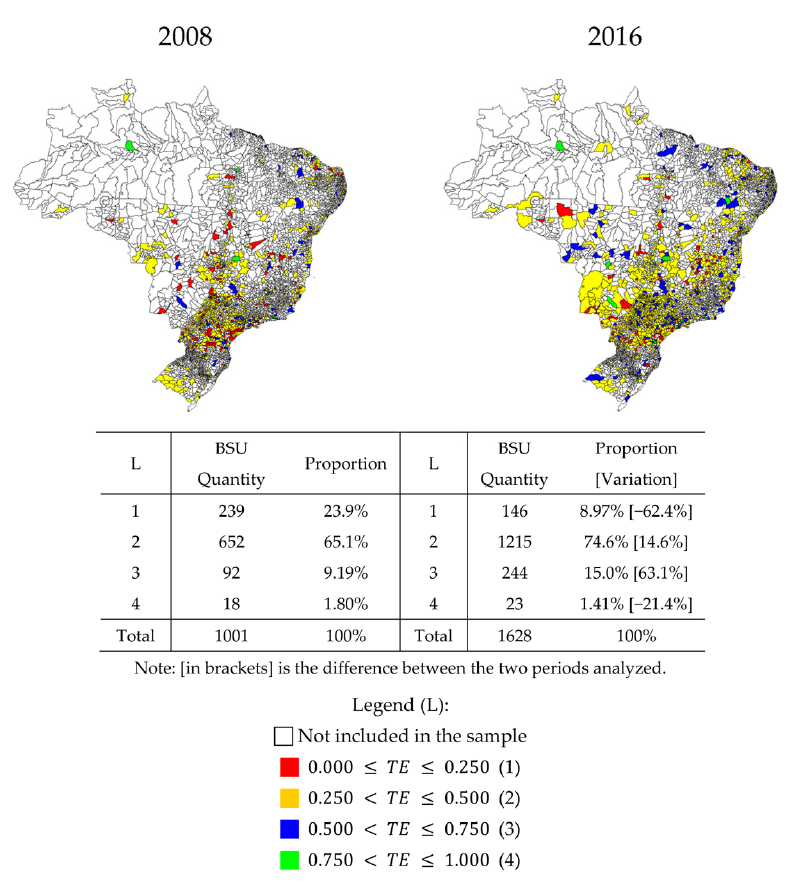
Figure 6. Spatial distribution of sectoral technical e ffi ciency ( TE ) for basic sanitation management in Brazil. Source: Author’s own elaboration based on the research